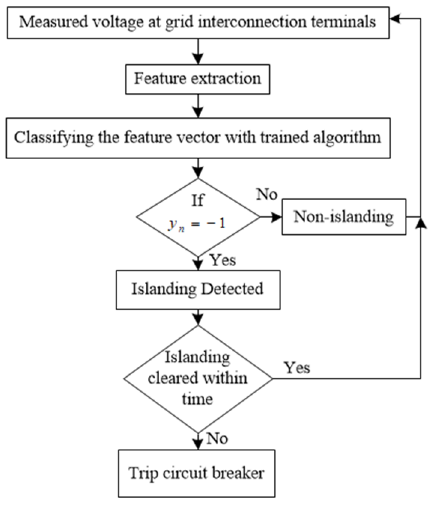
Figure 8. Flow diagram for islanding detection in single phase grid connected system using the trained support vector machine (SVM).